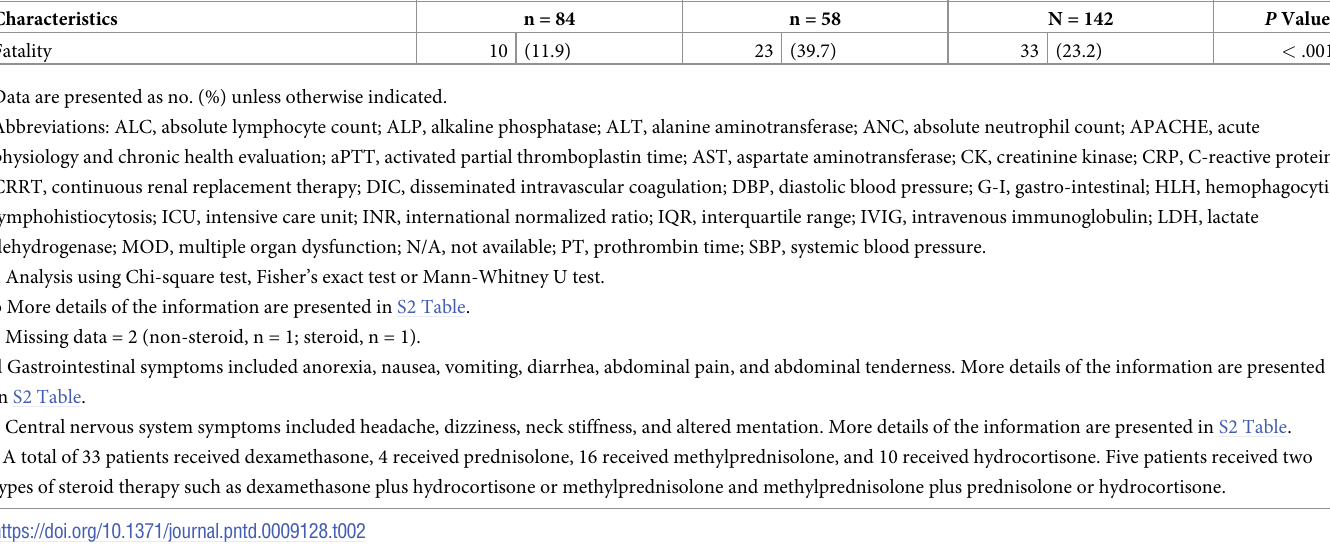
White blood cell count within 48 hours post-steroid treatment increased to 3,200/ μ L from 1,700/ μ L before treatment ( P < .001). Platelet count also increased to 60.0 × 10 3 /mm 3 com- pared to a pre-treatment value of 51.5 × 10 3 /mm 3 ( P = .033). Aspartate aminotransferase (AST)/alanine aminotransferase (ALT) levels increased to 416/129 U/L post-treatment from 304/99 U/L pre-treatment ( P = .024/ P = .026), and blood urea nitrogen (BUN) levels increased to 22.8 mg/dL post-treatment from 16.1 mg/dL pre-treatment ( P = .021). Body temperature ( P < .001), albumin ( P = .005), hemoglobin ( P < .001), and hematocrit ( P < .001) levels were sig- nificantly lower post-treatment compared to pre-treatment values (Table